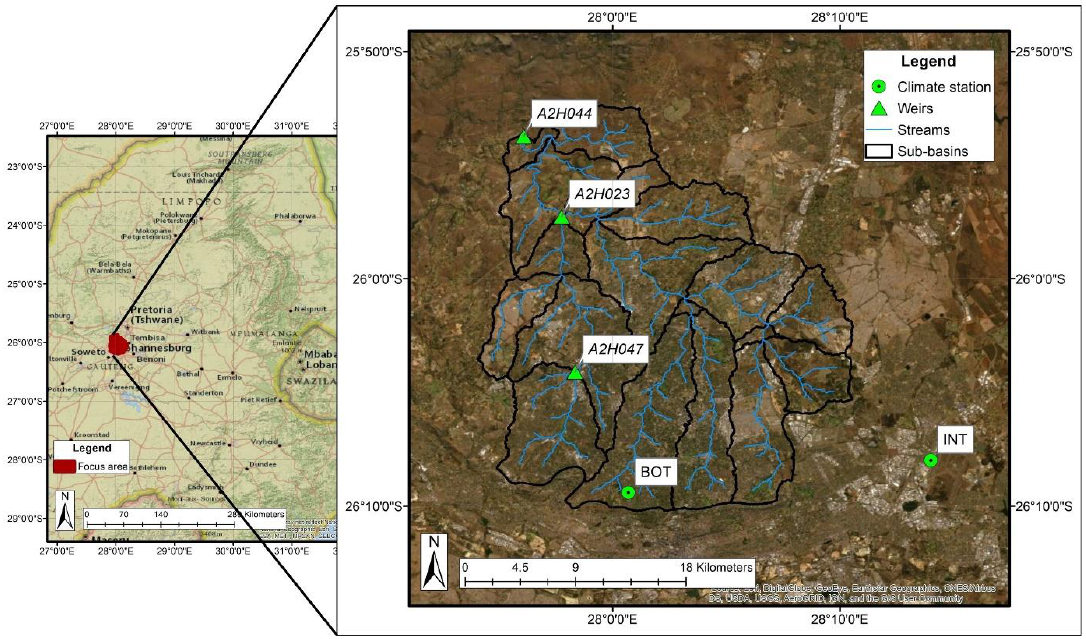
Figure 1. The study area with sub-basins, weirs and climate stations. The City of Johannesburg is located in the south with the capital city of South Africa, Pretoria, in the north.